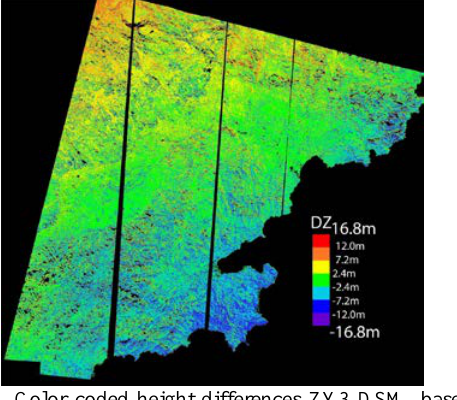
Figure 4. Color coded height differences Cartosat-1 Warsaw, left orientation by bias correction with affine transformation, right orientation by bias correction with shift; black areas masked out forest In the Cartosat-1 height model (figure 4) the forest areas are masked out due to the reference digital terrain model (DTM) with the points on bare ground. Figure 4 shows on left hand side the color coded height differences of the height model based on RPC-orientation with affine bias correction and on right hand side the differences based on RPC-orientation just with shift correction. The affine parameters of the orientation are highly significant with Student test values (size of parameter divided by its own standard deviation) in the average exceeding the value of 20.